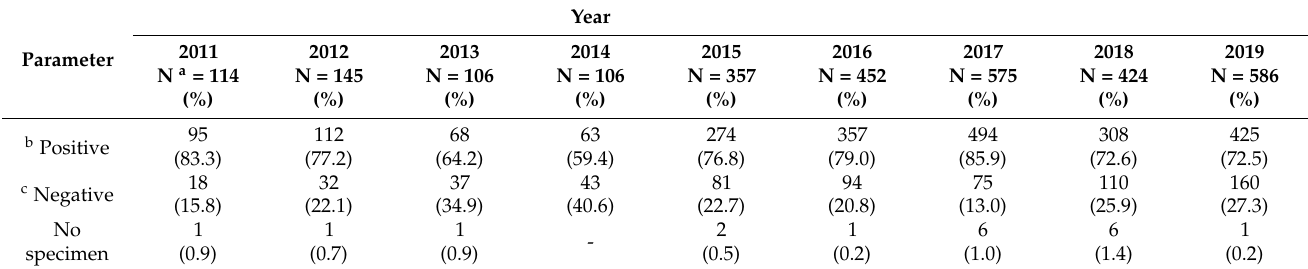
Table 1. Descriptive statistics of diarrhea clusters in Taiwan, 2011–2019.